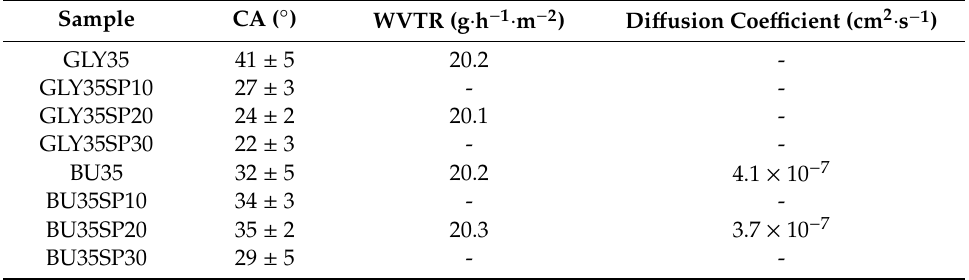
Table 2. Water contact angle, water vapor transmission rate, and water di ff usion coe ffi cient of samples plasticized with glycerol and 1,4-butanediol with 0, 10, 20, and 30 php of microalgal